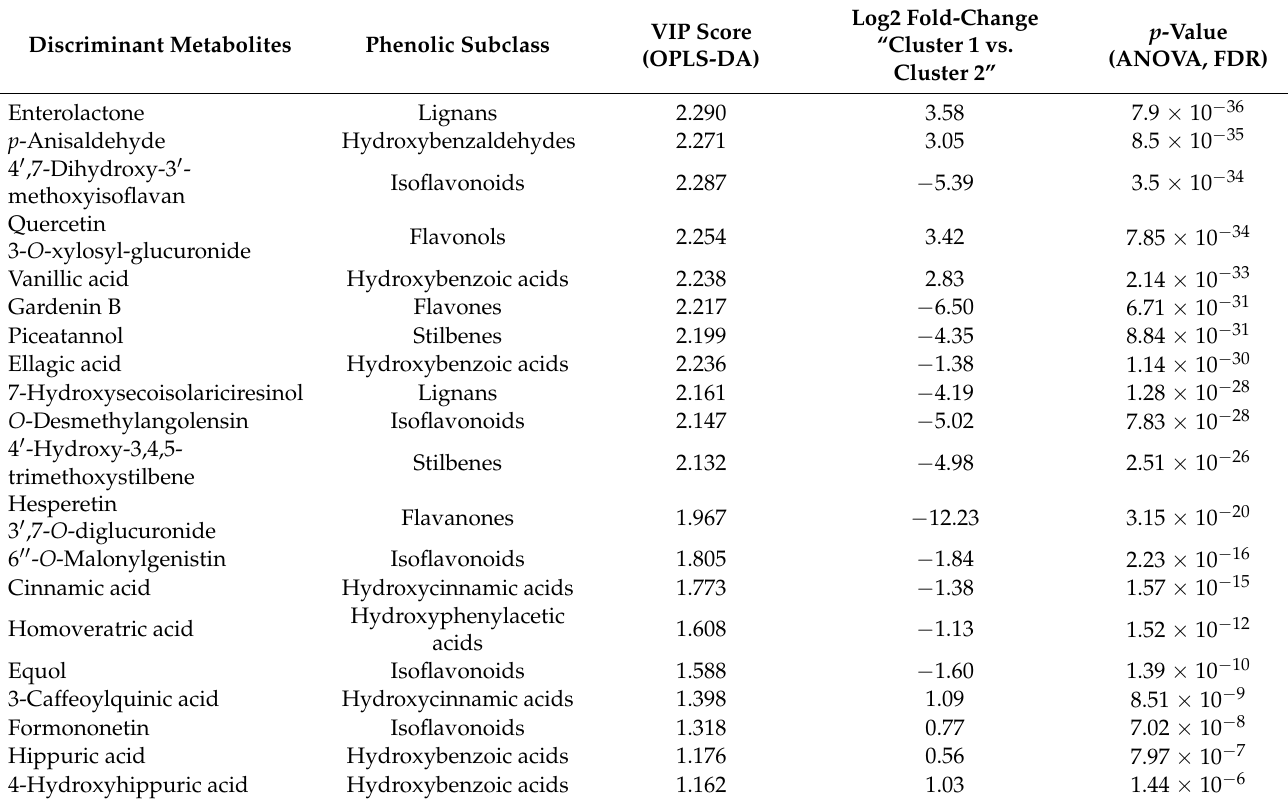
Table 2. VIP discriminant phenolic metabolites resulting from the OPLS-DA prediction model. Each compound is provided with its prediction (VIP) score, Log2 fold-change (FC) value, and p